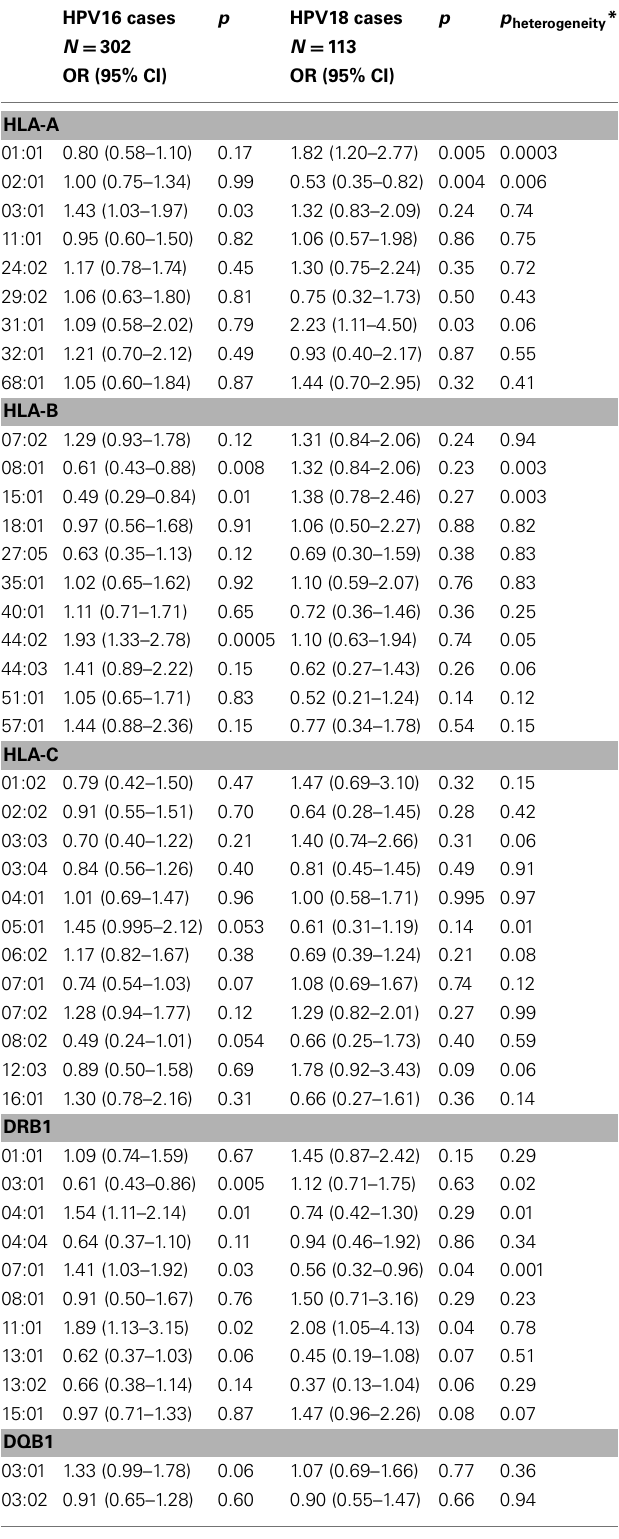
Table 3 |Association between HLA alleles and cervical cancer (regardless of histology) by HPV status, among Caucasians in theWestern cervical cancer study